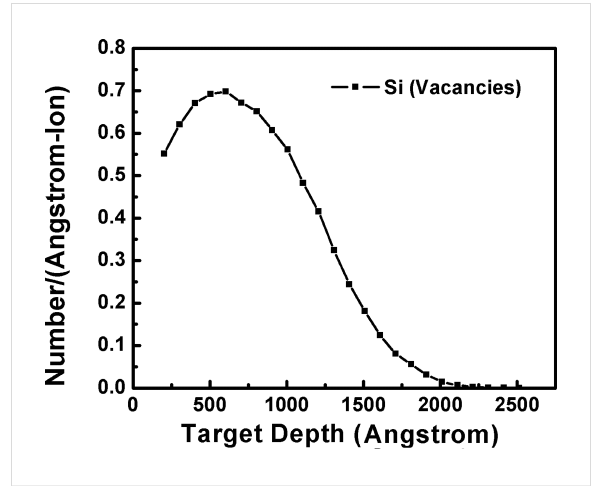
Figure 6: The distribution of silicon vacancies. The 50 keV neon ions were irradiated at normal incidence on 5 nm Pt film deposited on silicon